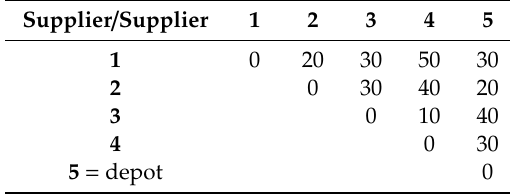
Table 5. Distance matrix ( D mn ).